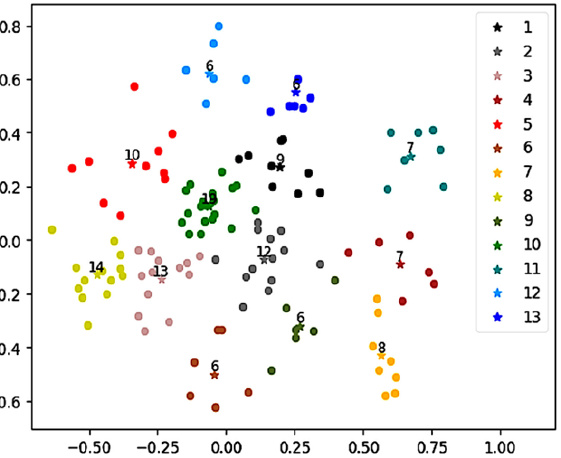
Figure 5. Grouping results of students in school_1. The axes represent the features obtained after dimensionality reduction. The data points for each group are marked by different colors.